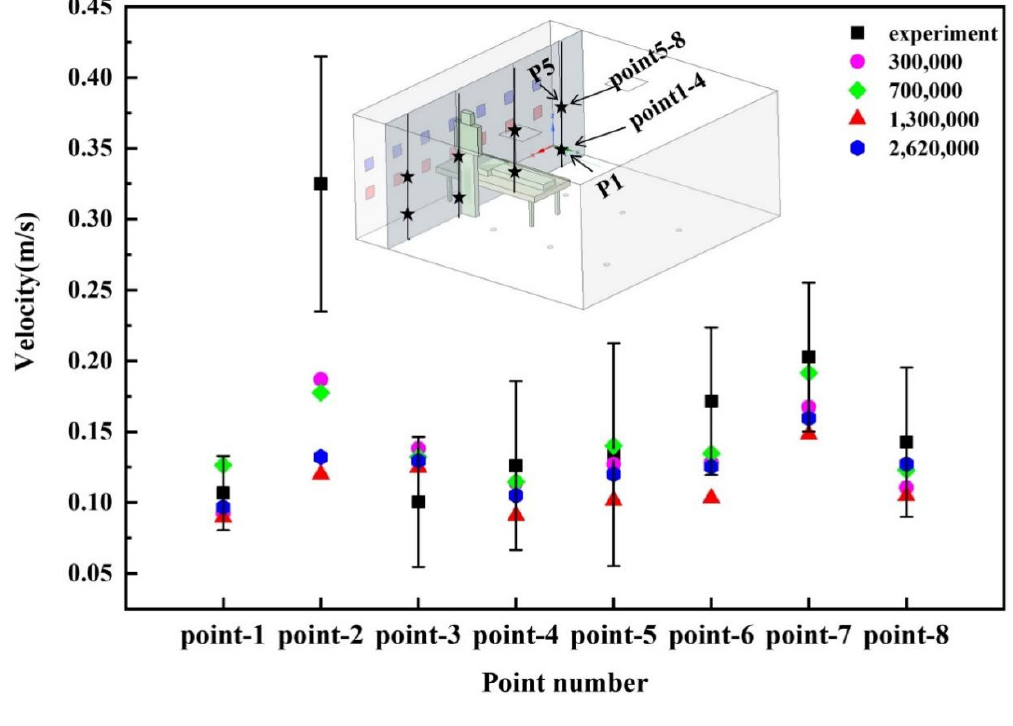
Figure 4. Grid independence study.